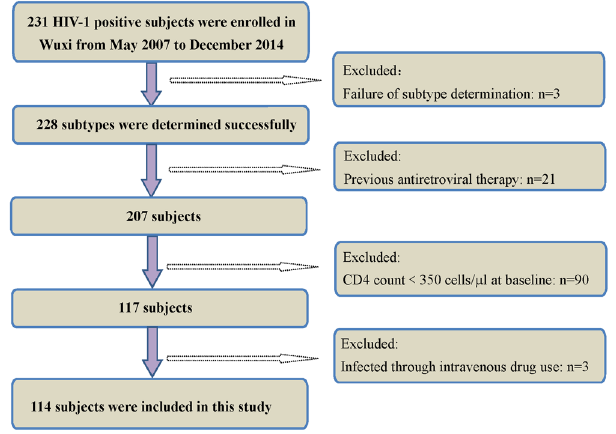
Figure 1. Flow chart of included and excluded study